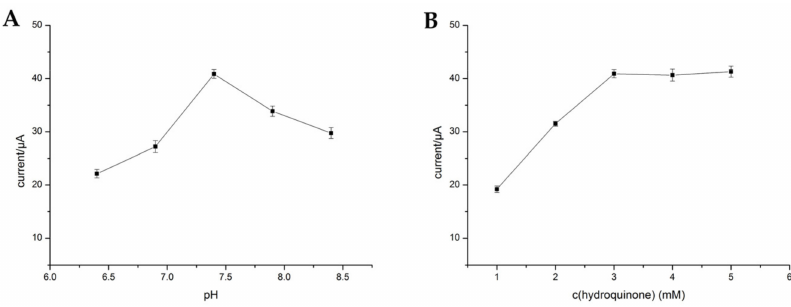
Figure 5. The influence of different pH ( A ) and the concentration of HQ ( B ).